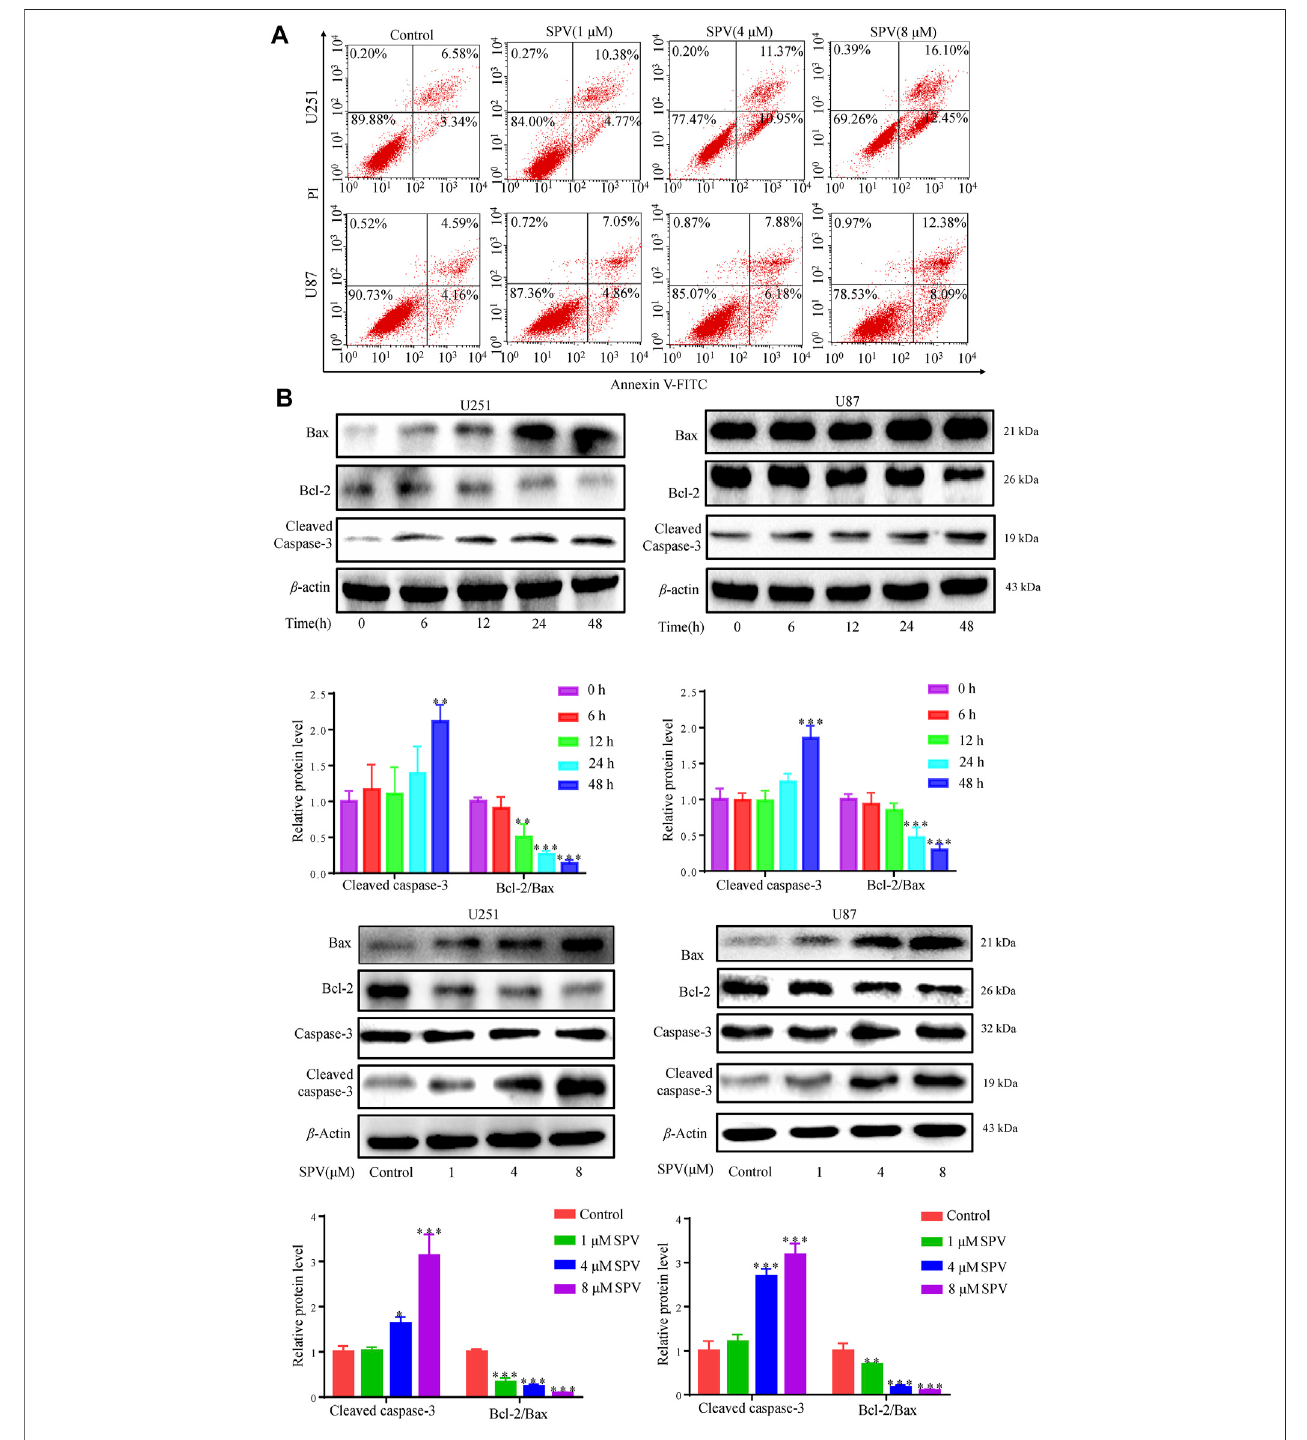
Figure3| Sempervirineinducedapoptosisingliomacells. (A) Cellsweretreatedwithsempervirine(0,1,4and8 μ M)for48 h,apoptoticcellswereanalyzedby fl ow cytometry. (B) Cellswereincubatedwithsempervirine(4 μ M)fordifferentdurationsortreatedwithvariousconcentrationsofsempervirinefor48 h.Theapoptosis-related proteins bax, bcl-2, Caspase-3 and cleaved caspase-3 were determined by Western blotting. Data are presented as the Mean ± SD ( n (cid:2) 3). * p < 0.05, ** p < 0.01 and *** p < 0.001 compared with the control group.